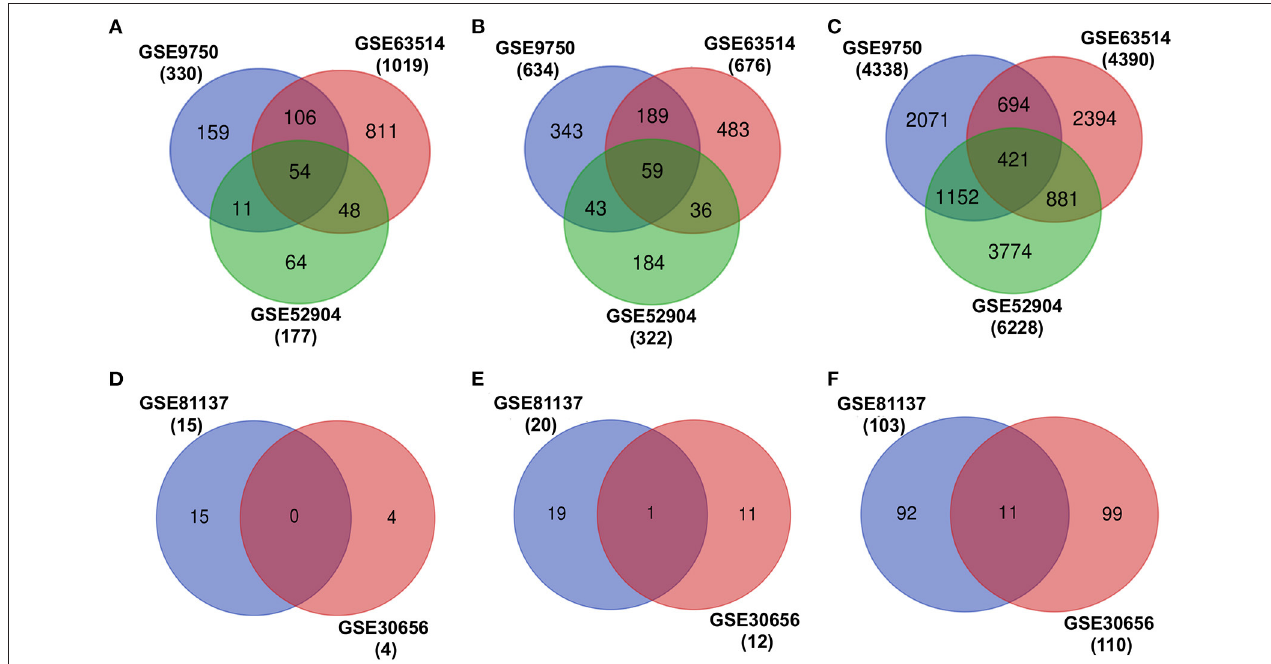
FIGURE 2 | Differential expression analysis of transcriptomic datasets associated with cervical cancer. (A–C) represent the overlap of upregulated, downregulated, and EG, respectively. (D–F) show the overlap of upregulated, downregulated, and expressed miRNAs,